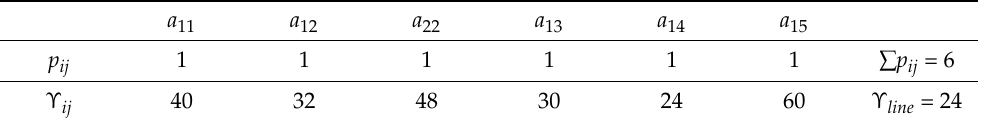
Table 1. Traditional ALB assignment.